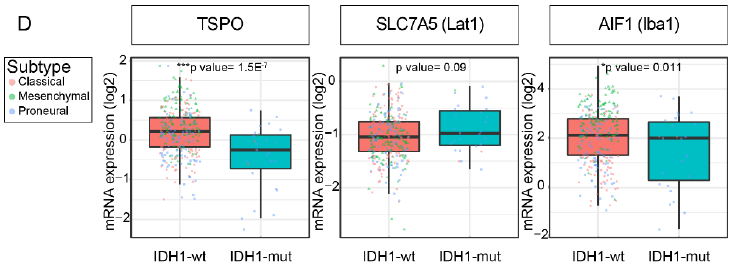
Figure 6. TSPO , solute carrier family 7 member 5 ( SLC7A5 ), and AIF1 expression analysis in a TCGA GBM cohort. Patient GBM samples of the TCGA database were analyzed using GlioVis [29]. ( A ) Gen expression levels in GBM compared to the tumor-free brain showed that expression levels for TSPO and AIF1 were significantly higher in GBM. P - value of Student’s t test is indicated (upper panel). Significant differences between the gene expression of TSPO and AIF1 were also detected for GBM subtypes. Statistical significance ( Tukey’s Honest Significant Difference ) is indicated, *** p < 0.0005 (lower panel). ( B ) Survival of patients with a high or low expression of TSPO , SLC7A5 , or AIF1 was analyzed. High TSPO or AIF1 expression was associated with significantly shorter survival, while high SLC7A5 expression levels were favorable for survival. Patient number indicated in graph. ( C ) A correlation between the genes TSPO , SLC7A5 , and AIF1 was performed. A significant positive correlation between TSPO and AIF1 ( Pearson’s r = 0.489) was observed, while no correlation between the other pairs could be seen. ( D ) Expression levels for TSPO and AIF1 were significantly higher in IDH WT GBM than in IDH MUT . P-value of Student’s t -test is indicated.